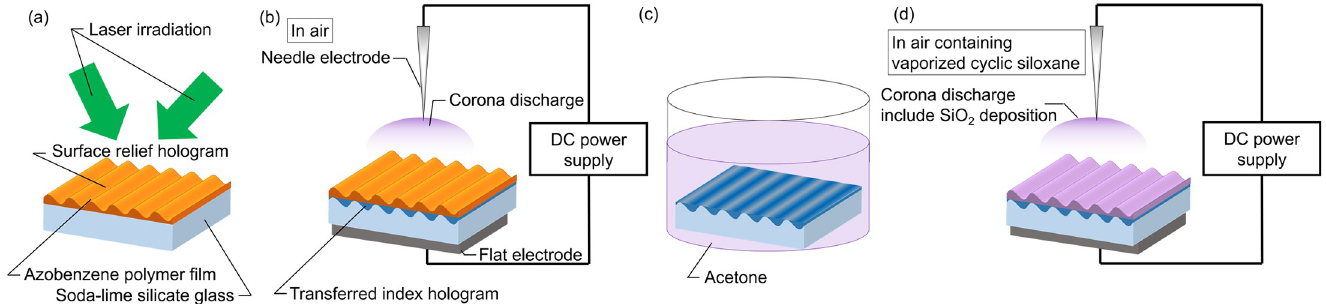
Fig 1. Schematic drawing of the experimental procedure. (a) Holographic recording. (b) Corona discharge. (c) Removal of the polymer. (d) Corona discharge deposition.